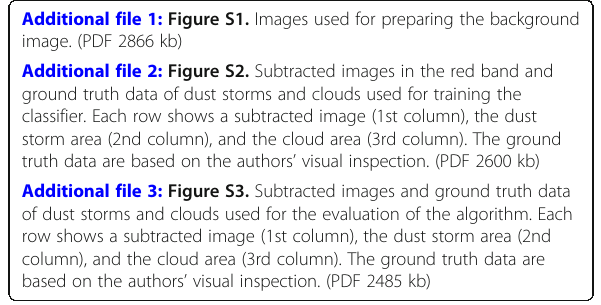
Fig. 7 The confusion matrix defining true positive, true negative, false positive, and false negative. True class means the ground truth based on the human operator ’ s inspection. Predicted class means